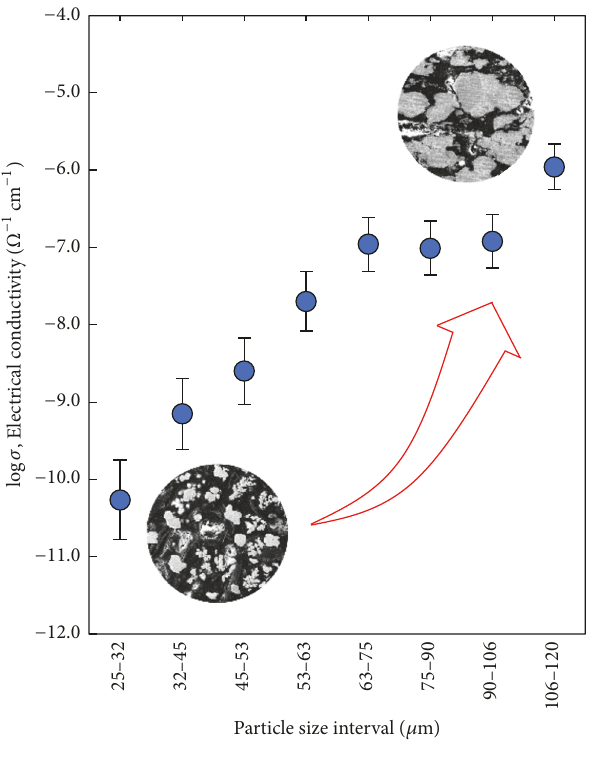
Figure 12: The copper filler particle size effect on electrical conduc-